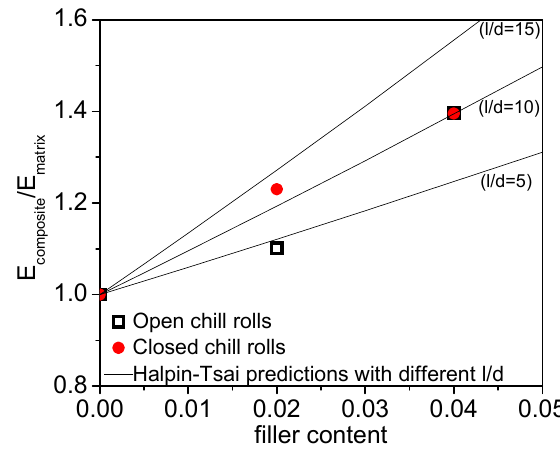
Figure 15. The relative tensile modulus as a function of filler content. The open square symbols represent the samples cooled with open chill rolls and the closed circles of the samples cooled with closed chill rolls. The solid lines represent Halpin-Tsai predictions using different filler aspect ratios.